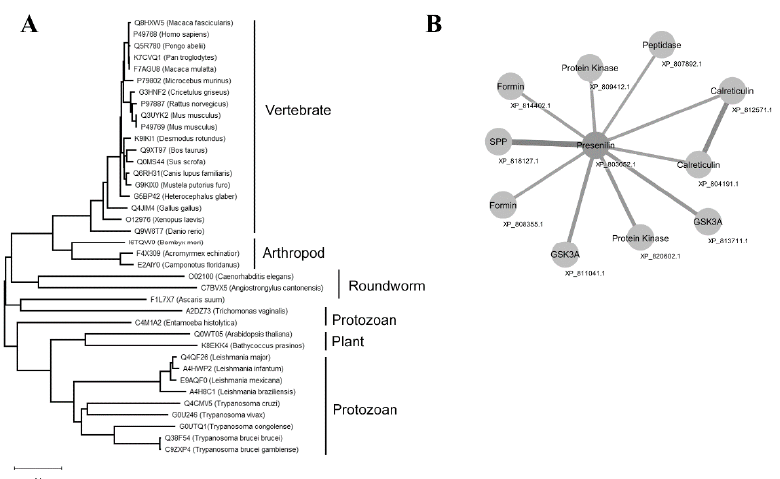
Figure 3. Phylogenetic relationship of PS and PS-like proteins and protein–protein interaction network of T. cruzi PS-like. ( A ) Amino acid sequences obtained from Uniprot server (http: // www.uniprot.org, search criteria name: “PS” and length: [300 to 800]) were aligned with Clustal W and the phylogenetic tree was constructed with the sequences aligned by the neighbor-joining algorithm using a CLUSTAL